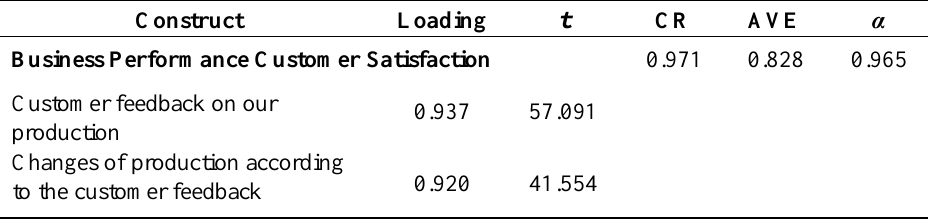
Table 1: Analysis of First Order